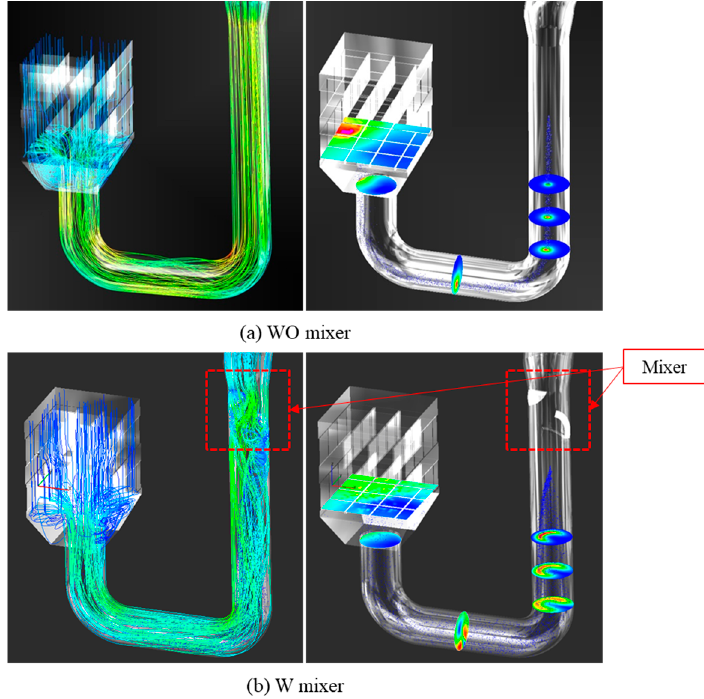
Figure 4. Flow stream (left) and urea droplet distribution (right) in the urea-SCR system.